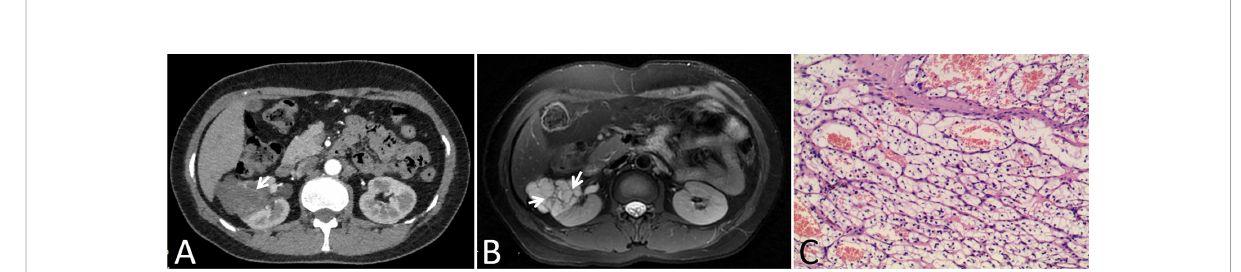
FIGURE 2 Images in a 46-year-old woman with a cystic mass in the right kidney. (A) Axial contrast-enhanced CT image shown a complex cystic mass that contained a few thin septa (arrow), (B) Axial T2-weighted MR image shown more septa (arrows) within the lesion than were depicted on the CT image, (C) This lesion was surgically removed and determined to be a renal clear cell carcinoma with cystic changes and glassy changes.